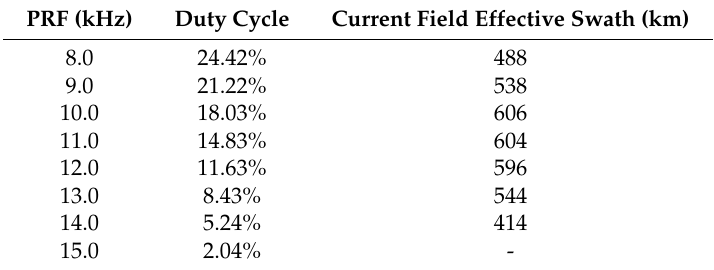
Table 4. Current field effective swaths (current velocity Std of 0.15m/s) with different values of